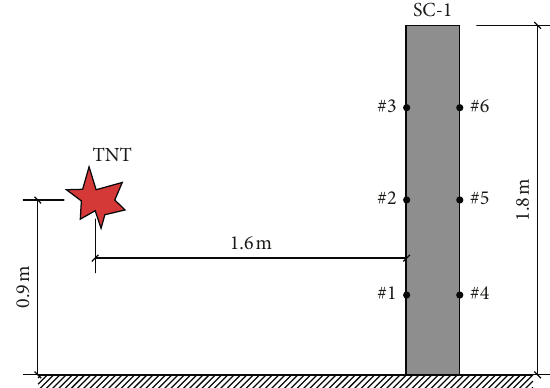
Figure 5: Measure points of